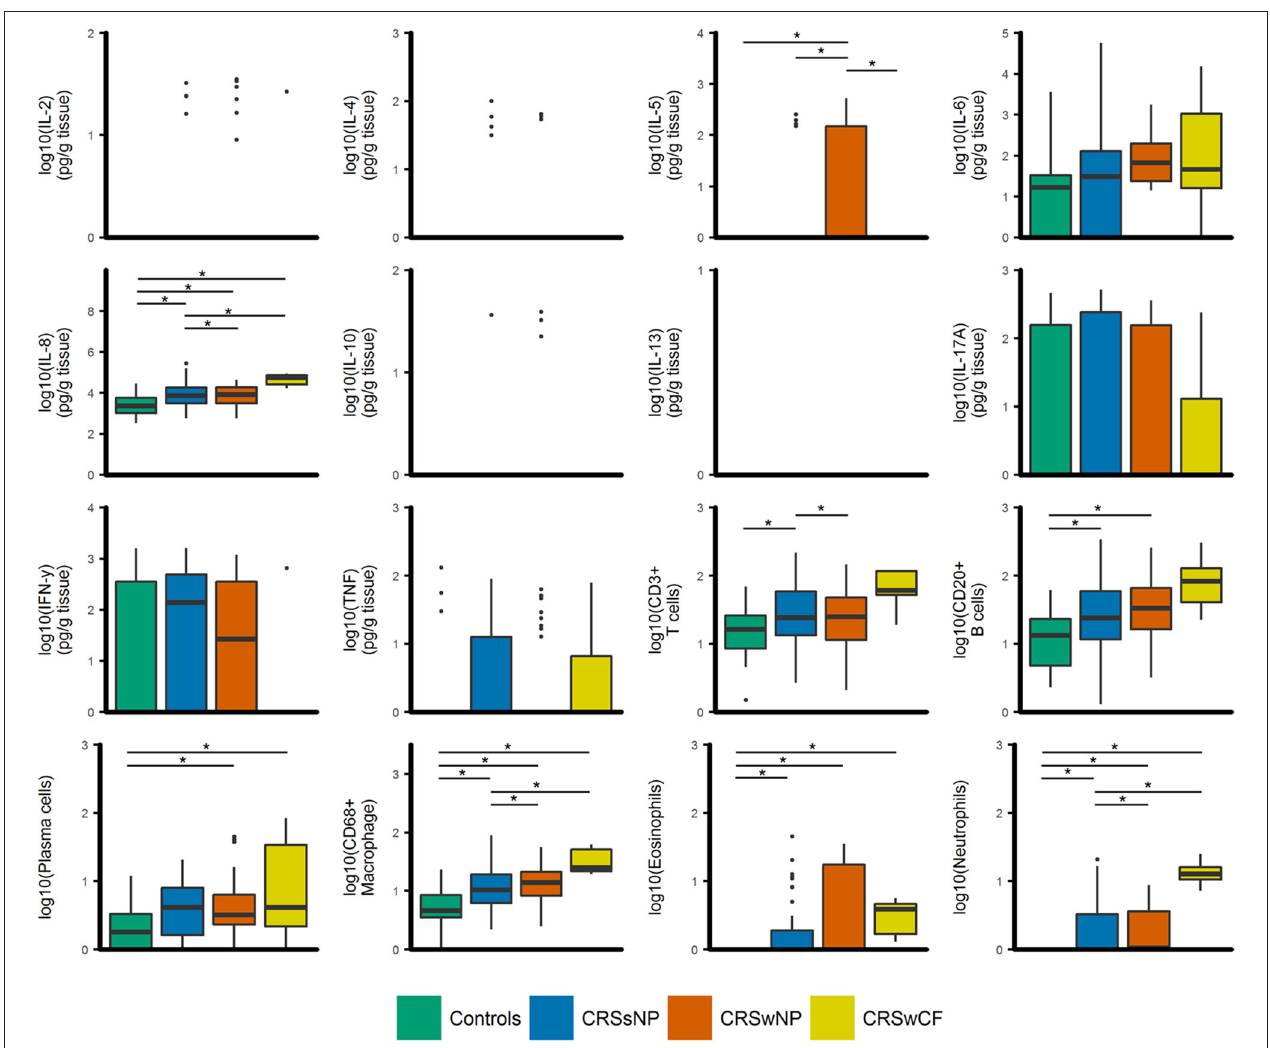
FIGURE 1 | Boxplots of inflammatory variables grouped by CRS phenotypic subtypes [controls ( n = 17), CRSsNP ( n = 46), CRSwNP ( n = 40), CRSwCF ( n = 7)]. All data are log-transformed for visualization. Values for cell counts are log-transformations of cell numbers per high-powered field. Box center lines represent median values, whiskers outline values up to 1.5 × the interquartile range (IQR), and remaining outlier values are presented as dots. For variables where boxes and whiskers are absent, all values in the range of the box and whisker [IQR + whiskers up to 1.5 × (IQR)] were equal to zero. *represents significant differences between groups (Dunn’s test of multiple comparisons with Bonferroni adjustment for multiple comparisons; α =